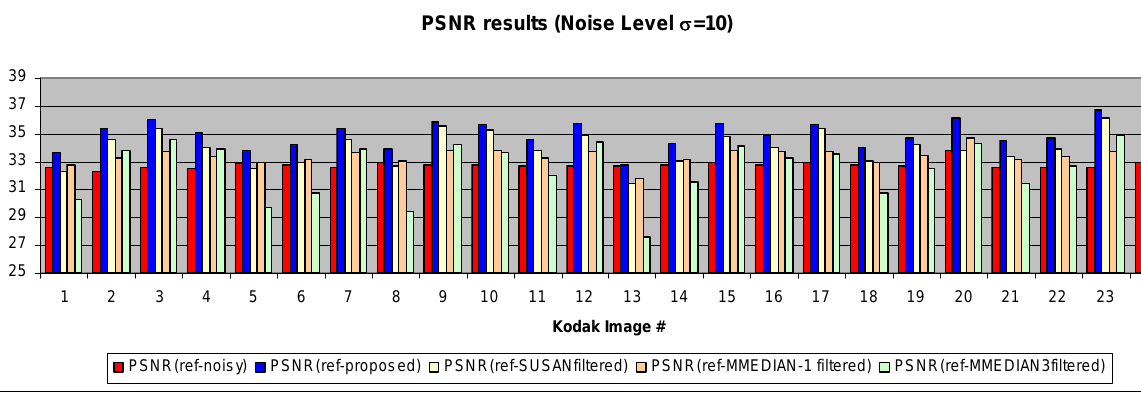
Figure 20 . Cont . PSNR results (Noise Level  =10)